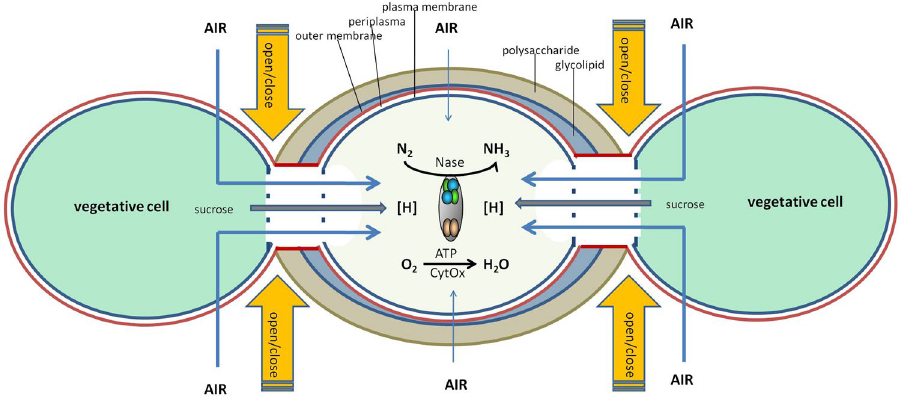
Figure 6. Model of a heterocyst with junctions to a vegetative cell at each side. The model emphasizes the situation for N d (see Fig. 1 legend). The heterocyst is characterized by an envelope comprising a glycolipid layer, which forms the principal barrier to diffusion of gas (thin arrows), and a polysaccharide layer. The envelope surrounds a cell wall with an outer membrane, peptidoglycan layer, and plasma membrane. Whether or not air enters the heterocysts via the vegetative cells may be regulated by an open/close mechanism (conceptually depicted by orange arrows). O 2 is respired, producing ATP. N 2 and O 2 compete for electrons that are imported as sucrose from the vegetative cells. The pores at the ends of the heterocysts may sometimes contain